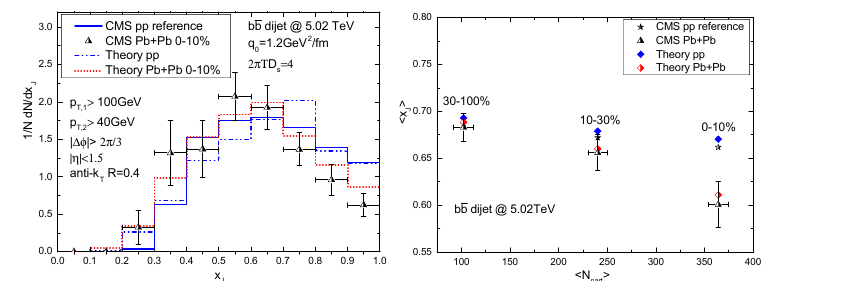
Figure 11. Left: normalized x J distribution of heavy flavor dijet in p + p and central Pb + Pb collisions compared with the smeared p + p baseline and experimental data in A + A collisions. Right: averaged values of x J of b ¯ b dijet production at di ff erent centralities compared with experimental p + p references and Pb + Pb data. The data are taken from CMS measurement